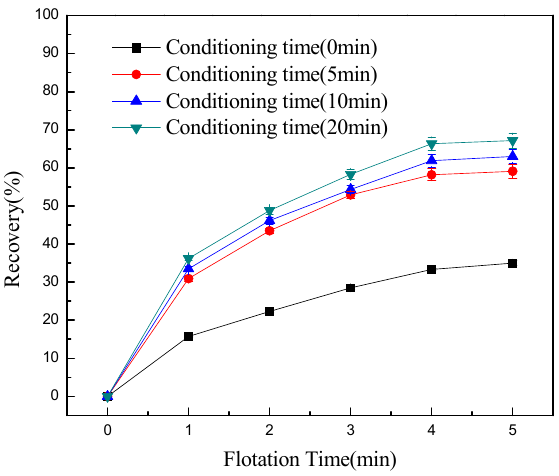
Figure 9. Effect of conditioning time under nitrogen atmosphere on the recovery of mixed minerals, with pyrrhotite and chlorite mixed at a ratio of 10:1 (pH = 9.0 ± 0.2; C(potassium amyl xanthate) = 1 × 10 − 4 mol/L; C(MIBC) = 1 × 10 − 4 mol/L; and Conditioning time = 5 min).